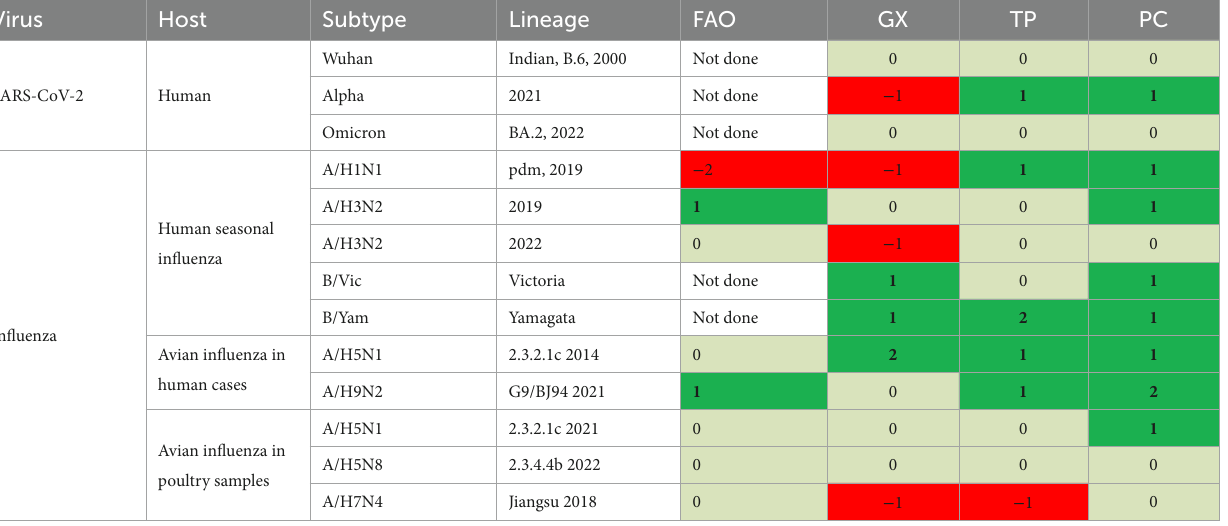
TABLE 2 Comparison of limit of detection between evaluated and standard